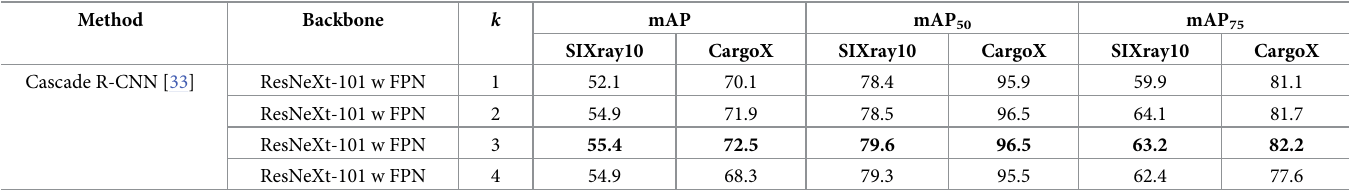
Table 1. Effect of the number of parallel 3 × 3 convolutional operations ( k ) in MDConv. Method